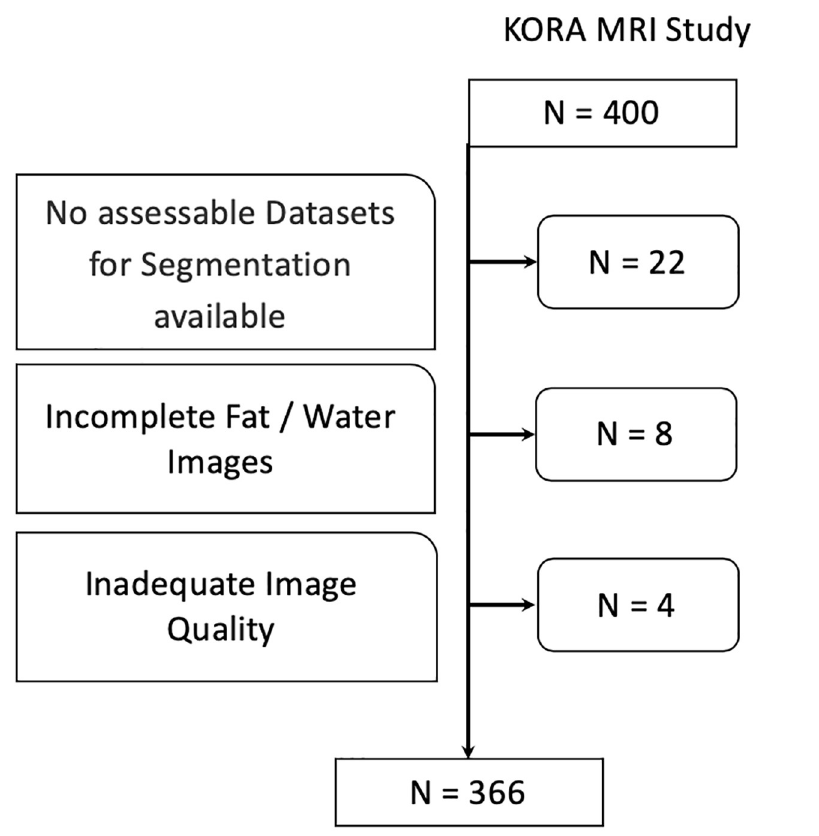
Fig 2. Inclusion flow chart. N = 366 study subjects were finally included for